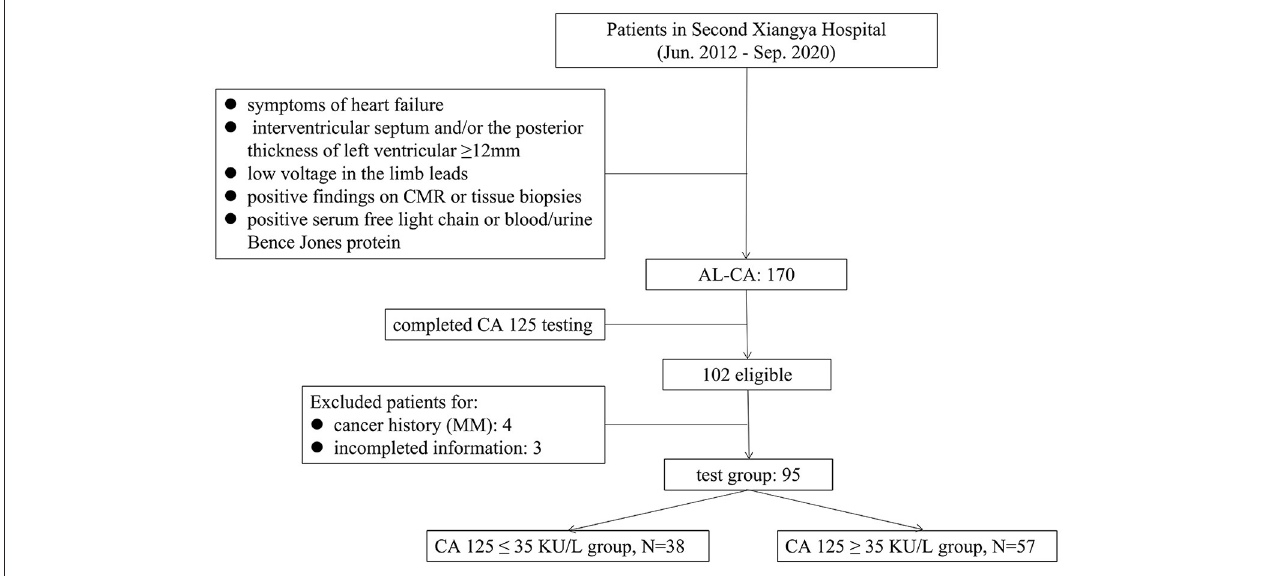
FIGURE 1 | Flowchart for the study